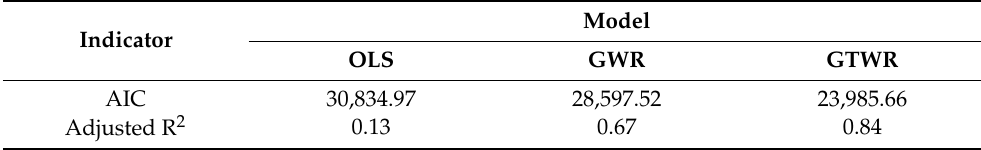
Table 3. Model comparison results.